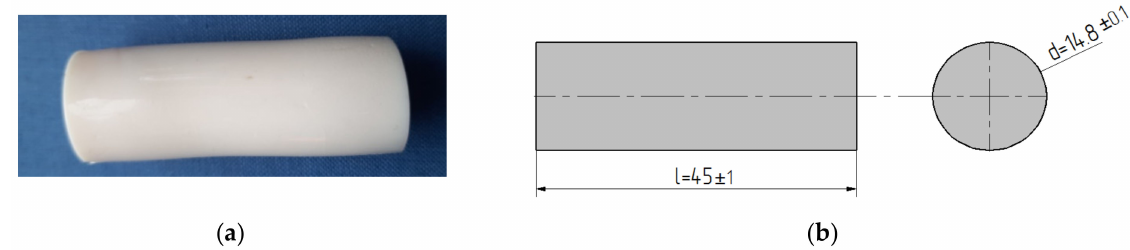
Figure 1. Schemes: ( a ) Cylindrical epoxy specimen after curing; ( b ) Dimensions in mm of epoxy specimen.